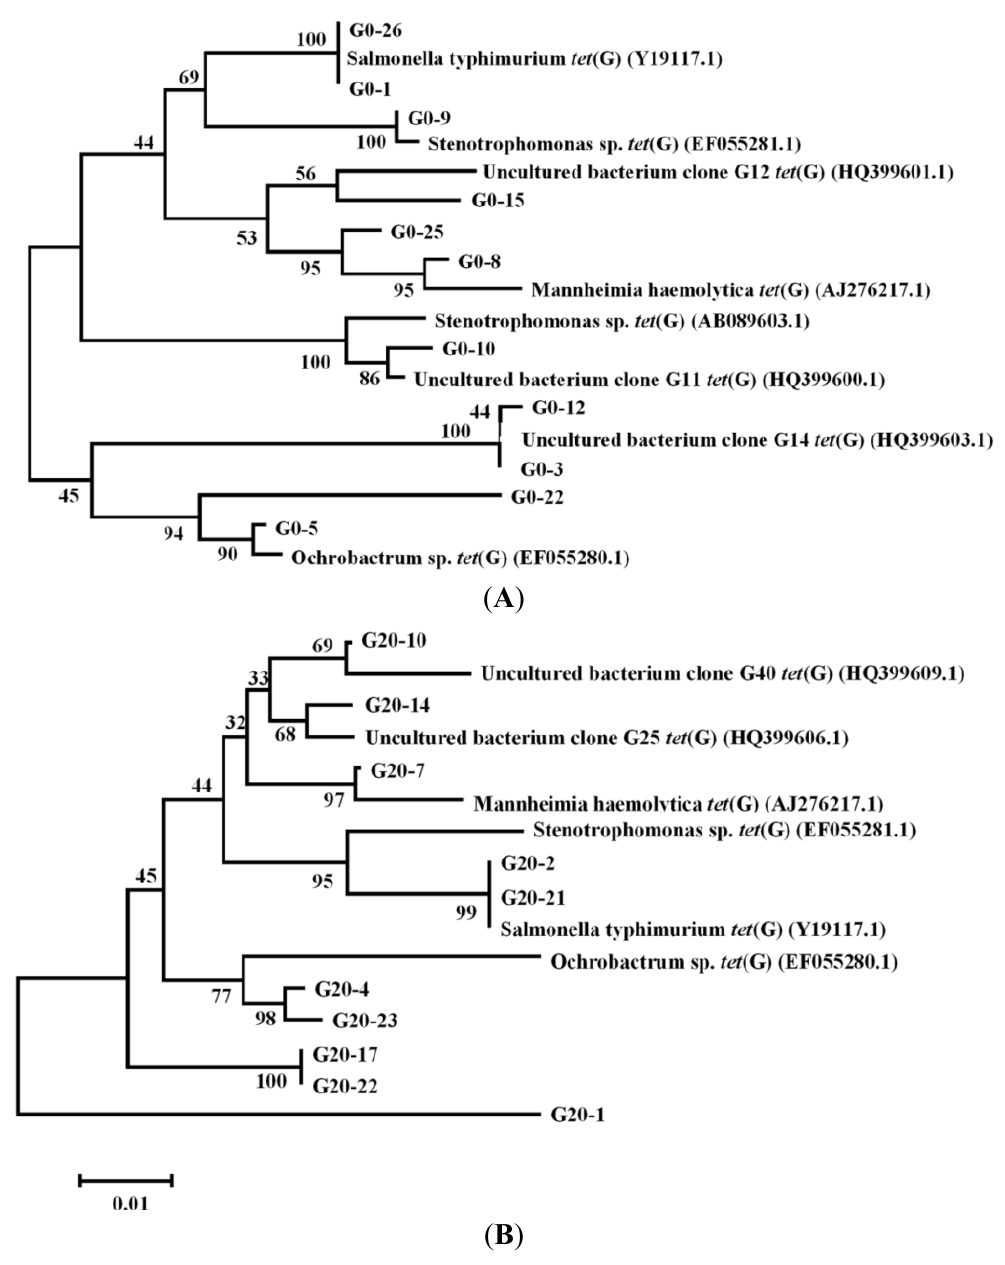
Figure 6. Neighbor-joining phylogenetic analysis of tetG diversity in activated sludge of D6-0 ( A ) and D6-20 ( B ). The tree was constructed using MEGA version 5.05 and bootstrap analysis with 1000 replicates was used to evaluate the significance of the nodes. D6-0: sludge fed with 0 mg/L tetracycline for 6 days; D6-20: sludge fed with 20 mg/L tetracycline for 6